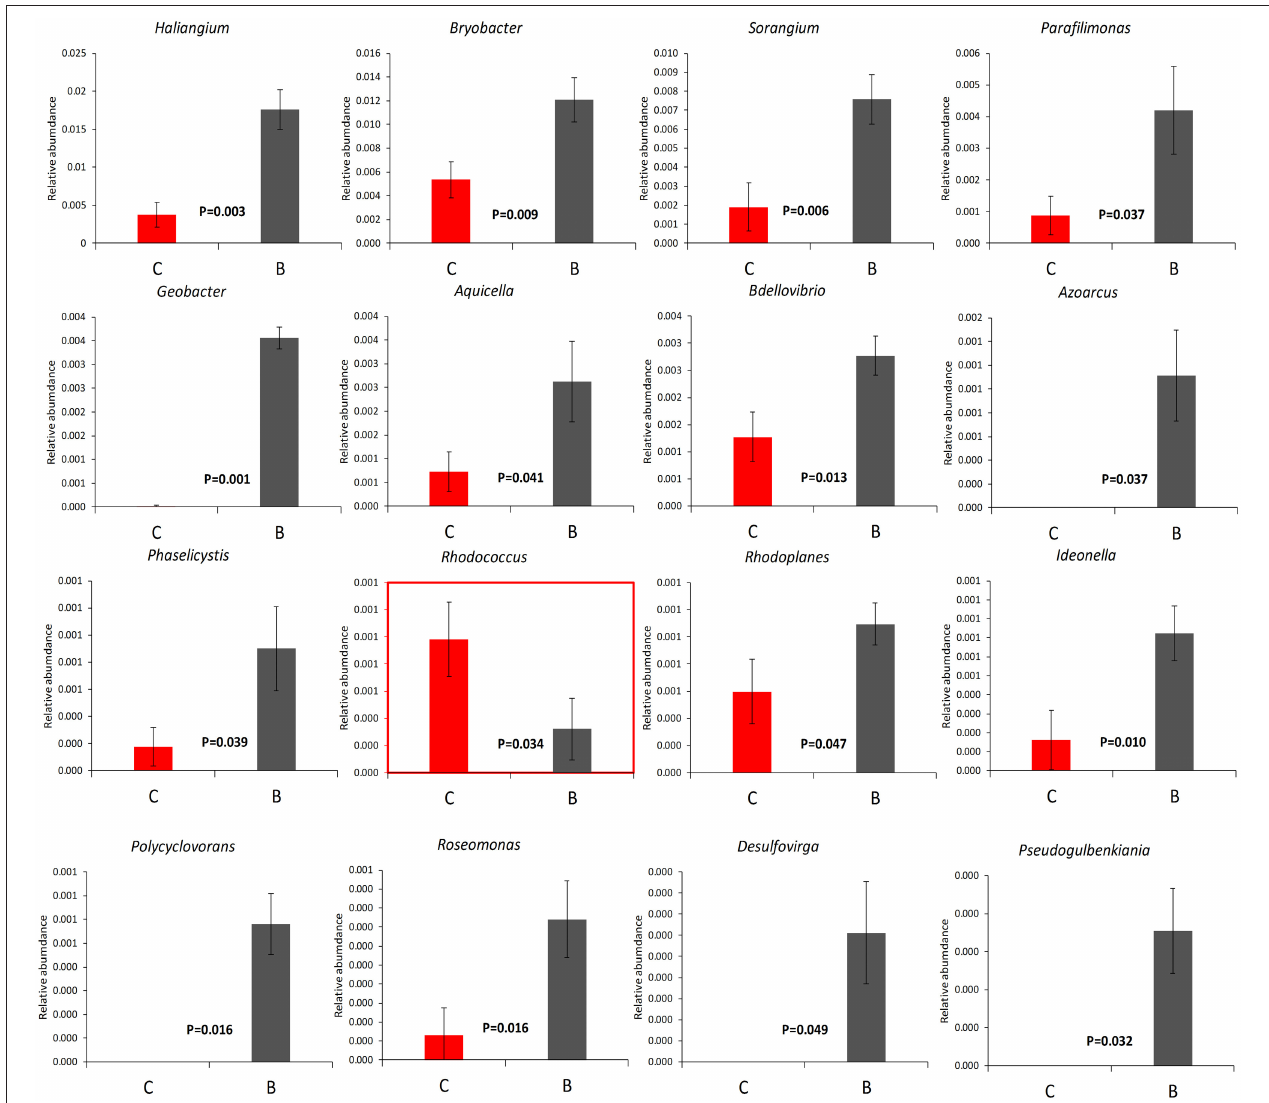
FIGURE 7 | The relative abundance of 16 significant bacterial genera. B: Intercrop, C: Monoculture. P -values were calculated through the DMRT test and are mentioned in between both columns, mean ± standard error.